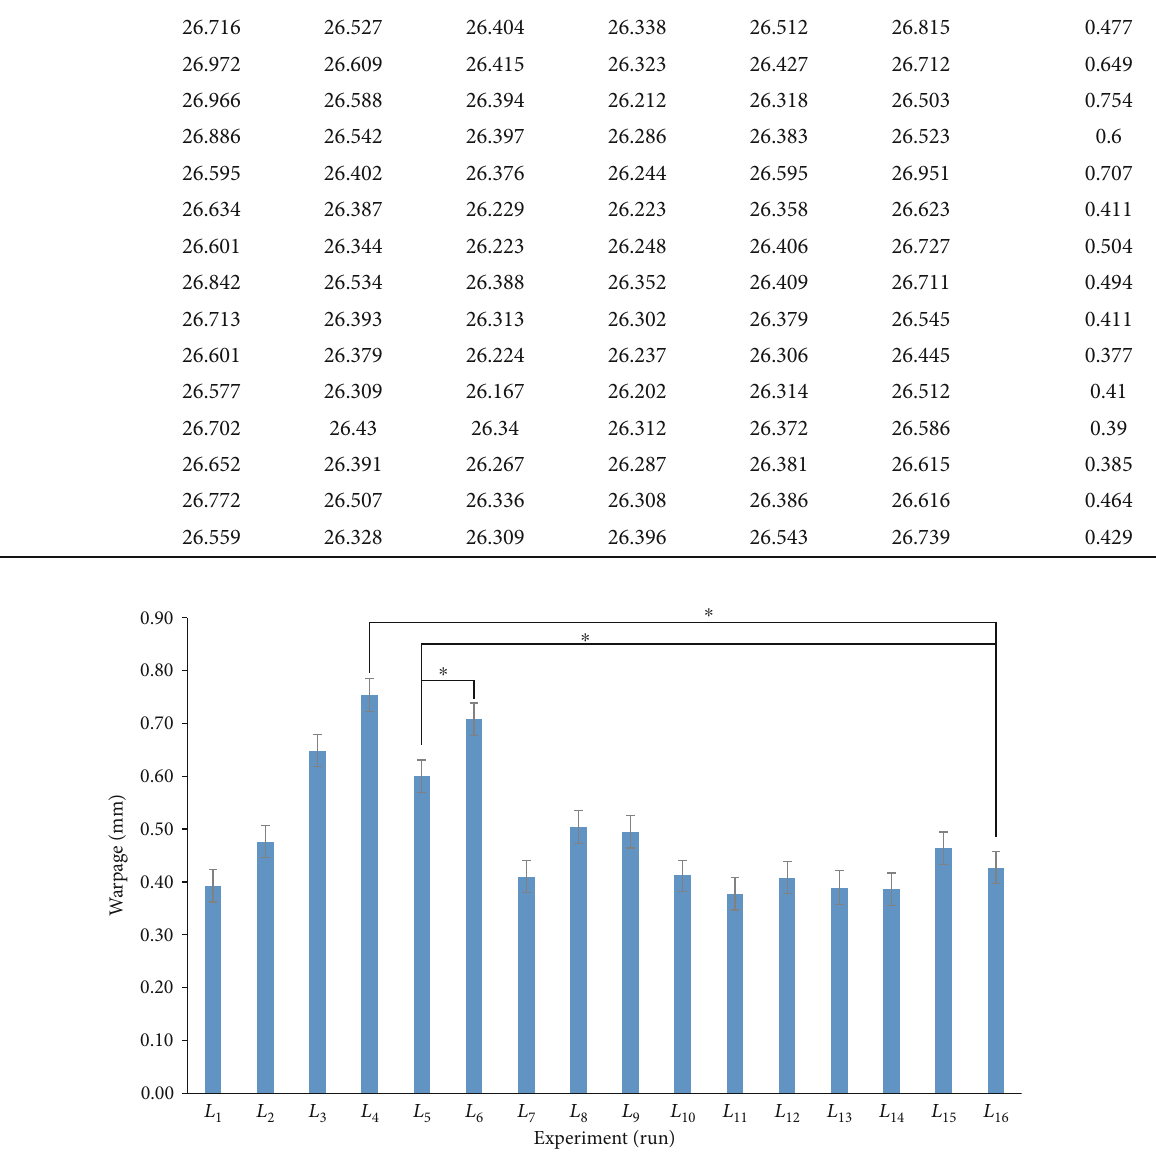
Figure 9: Warpage analysis for the p value of various process parameters in experiments ( ∗ p < 0 : 5 ). Table 6: Signal-to-noise (S/N) ratio reactions of warpage of the thin-wall part for the experiment (with thin-wall injection